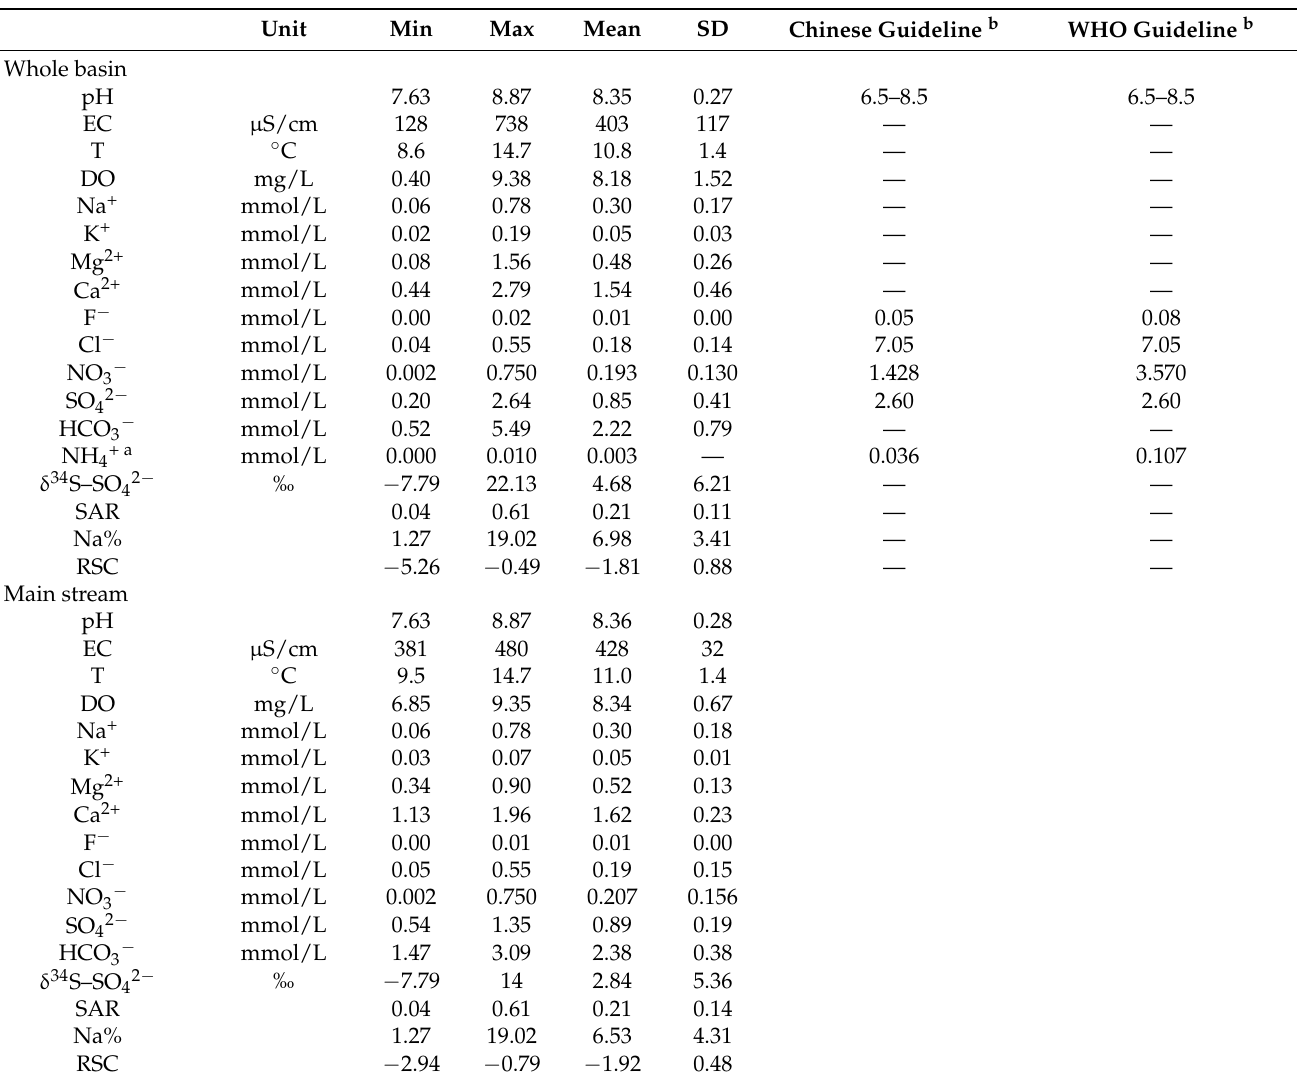
Table 1. Statistical result of hydrochemical compositions, parameters, δ 34 S values, SAR, Na%, and RSC of Chishui River